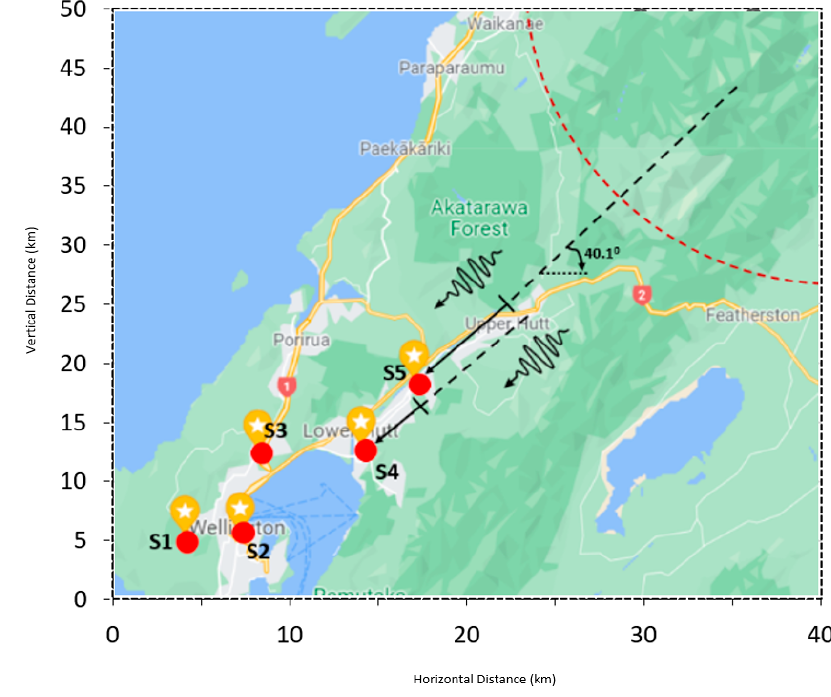
Figure A1. Scenario 1.